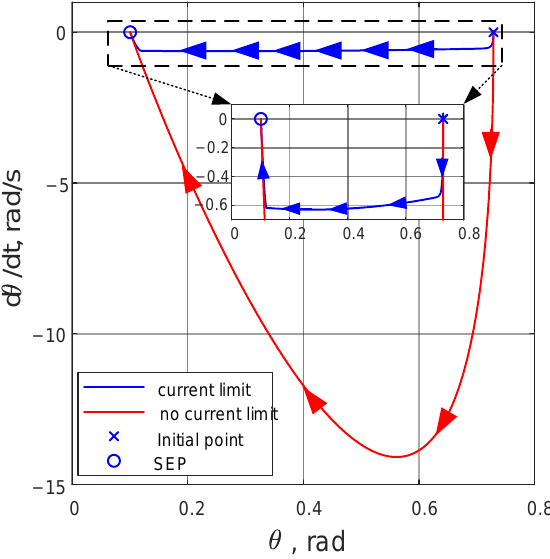
Figure 4. Phase portrait for different systems with the same initial operation point ( 0.2π, 0 ), red curve: trajectory of the system without current limitation; blue curve: the trajectory of the system with current limitation.